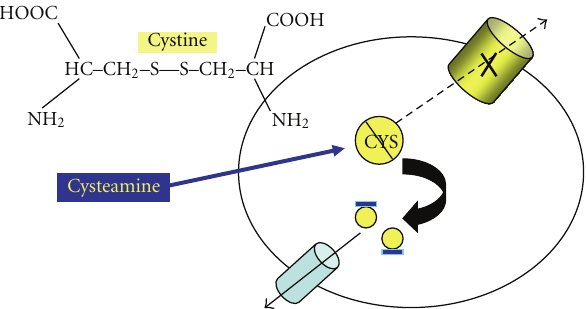
Figure 3: Cystine-depleting e ff ect of cysteamine. Cystine forms mixed sulfides with intralysosomal cystine that are able to e ffl ux into the cytoplasm via alternative lysosomal